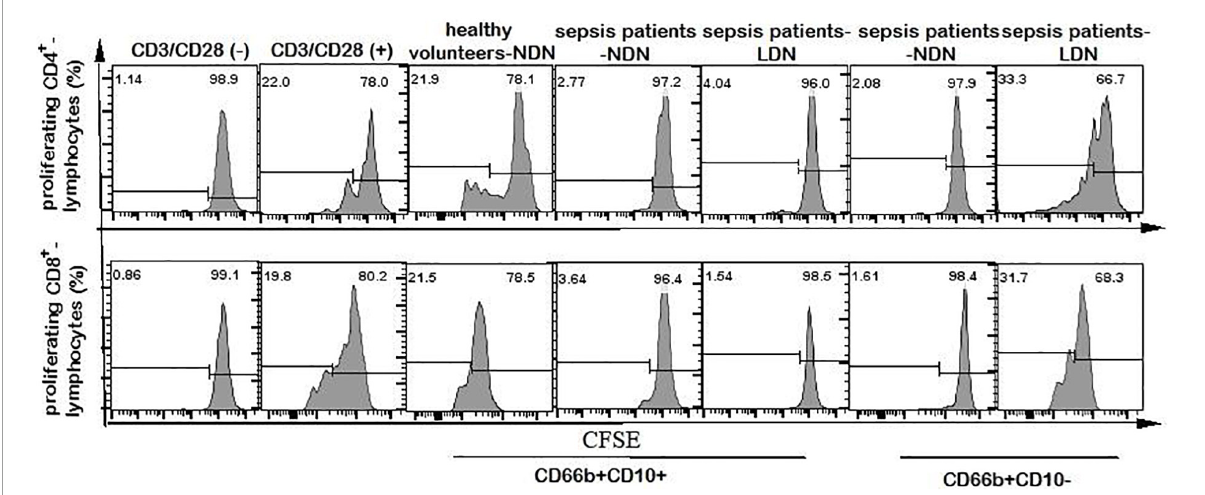
FIGURE6 Flow cytometry chart of CD4 + and CD8 + lymphocyte proliferation. The first column of CD3/CD28 (–) represents the flow cytometry chart of lymphocyte proliferation without CD3/CD28 antibody stimulation, as a negative control. The second column of CD3/CD28 (+) represents the flow cytometry chart of lymphocyte proliferation stimulated by anti-CD3/CD28 antibody as a positive control. Columns 3–7 represent the flow cytometry chart of lymphocyte proliferation after stimulation by anti-CD3/CD28 and co-culturing with different neutrophils in 1:1 ratio for 72